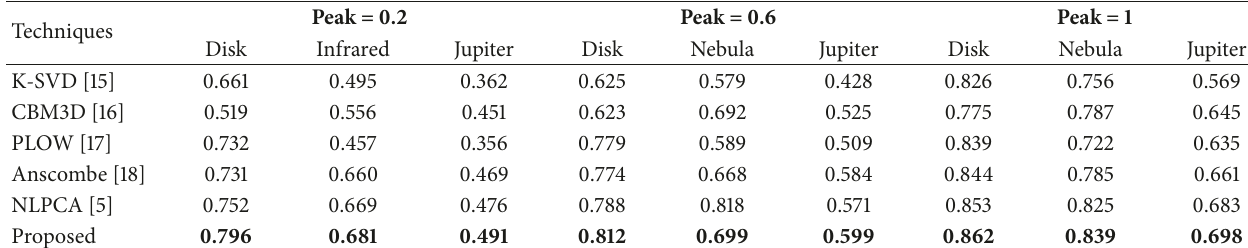
Table 2: SSIM comparison.